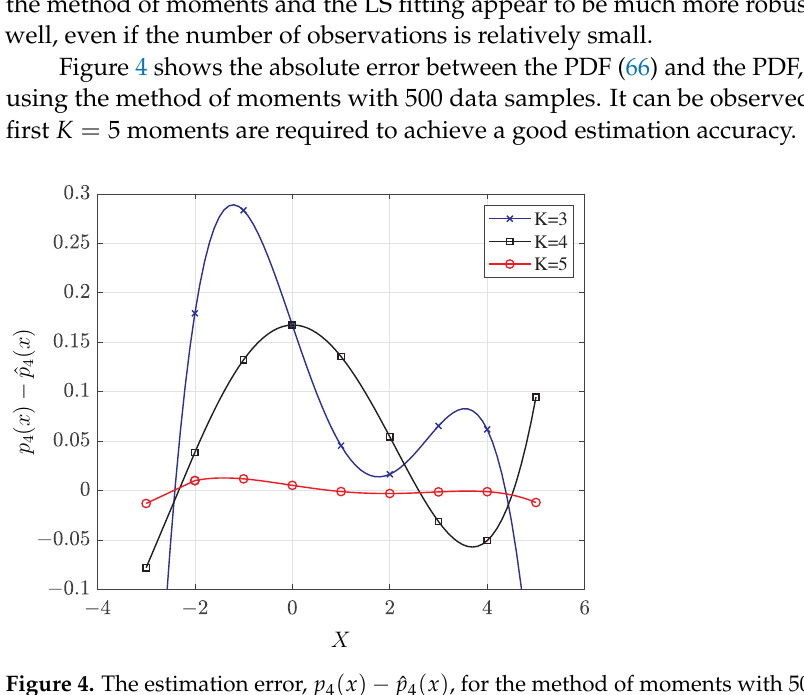
ˆ p 4 ( x ) , for the method of moments with 500 data −